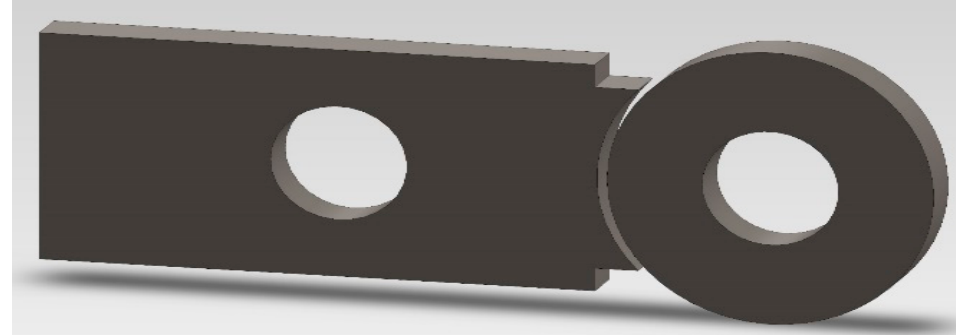
Figure 2. Sample and counter-sample used in the Amsler-A135 Machine.